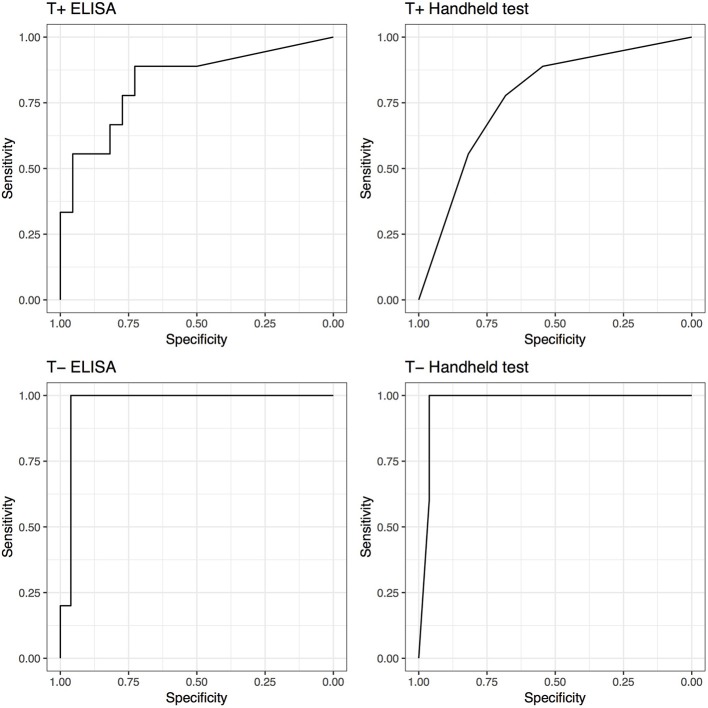
Receiver operating characteristic (ROC) curves for ELISA and handheld SAA tests for horses that received antimicrobial and/or anti-inflammatory therapy (T+) and horses that did not (T−).